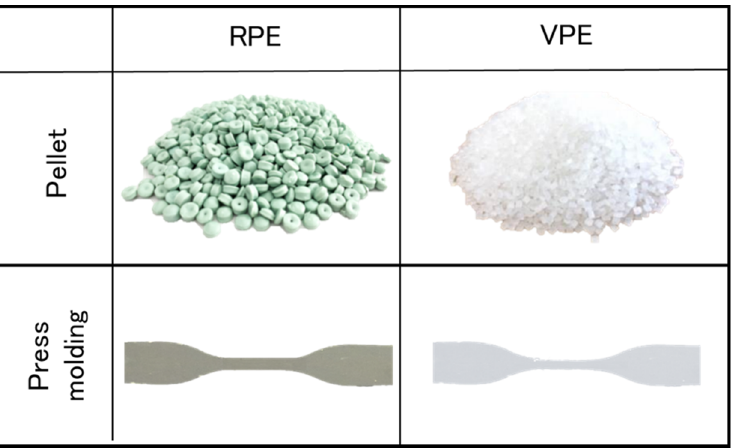
Figure 2. Images of the recycled polyethylene (RPE) and virgin PE (VPE) pellets and moldings.